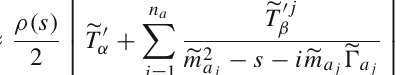
(cid:26) (cid:26) (cid:26) (cid:26) (cid:15) T (cid:3) j (cid:26) (cid:26) ρ( s ) β 2 s = (cid:15) m 2 aj − i (cid:15) m aj (cid:15) (cid:6) aj